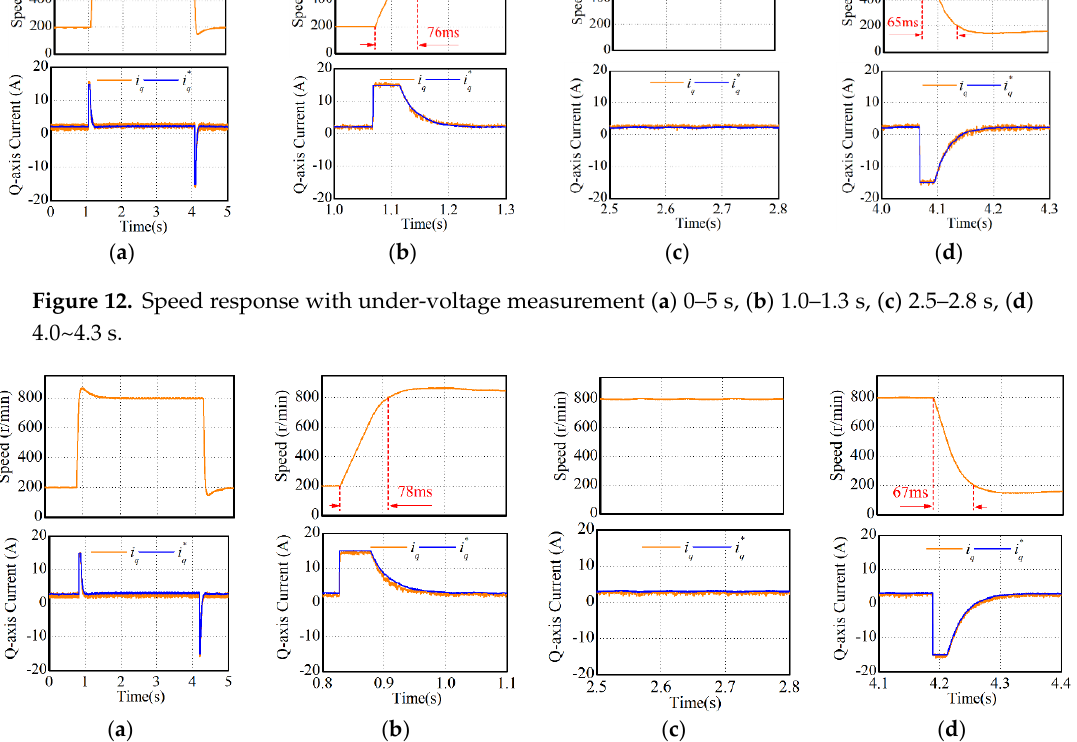
Figure 13. Speed response with over-voltage measurement: ( a ) 0 – 5 s, ( b ) 0.8 – 1.1 s, ( c ) 2.5 – 2.8 s, ( d ) 4.1 – 4.4 s.